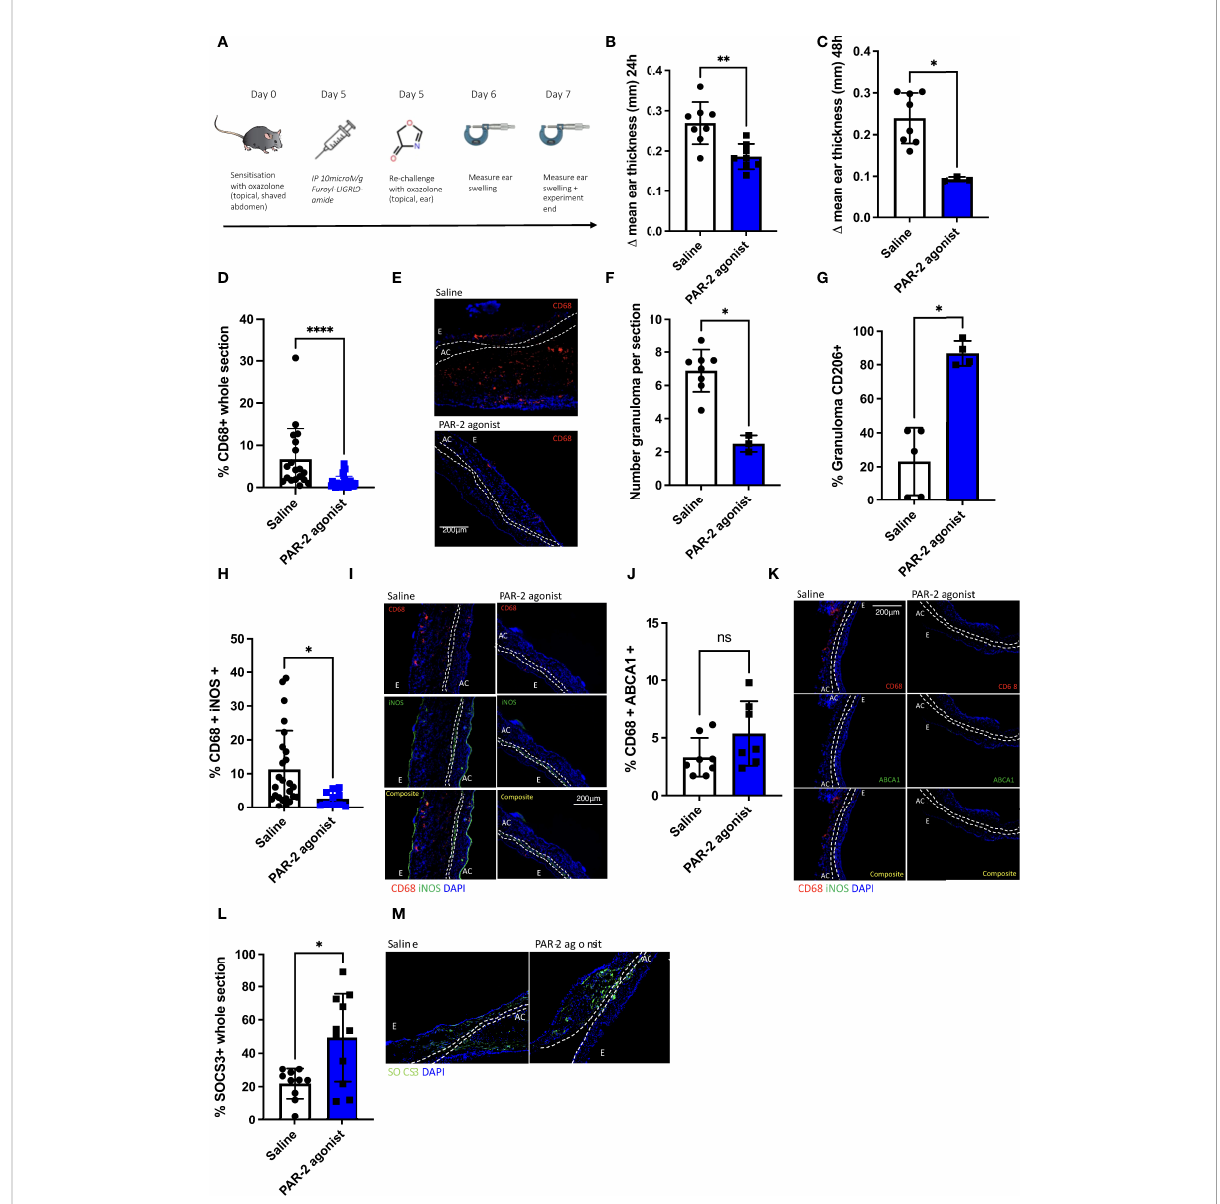
FIGURE 2 PAR-2 signalling delivers a protective phenotype in oxazolone induced delated type hypersensitivity. (A). Schematic illustrating the experimental protocol. C57BL/6 (WT) mice were sensitised on the abdomen with oxazolone on day 0 and re-challenged on day 5 on one of the ears with oxazolone, and on the other ear with vehicle alone. Immediately prior to re-challenge, mice received either IP saline (n= 8) or 10microM/g PAR-2 agonist (n= 7). 24 and 48 hours following re-challenge (days 6 and 7), ear swelling was quanti fi ed using a micrometer. Data are presented as D mean ear thickness (swelling of oxazolone-treated ear minus that of vehicle treated ear). At least 5 measurements were taken per ear and averaged. (B, C). D mean ear thickness at 24HRS (day 6) (B) and 48HRS (day 7) (C) post re-challenge with oxazolone. (D – M). Immuno fl uorescence offrozen sections through oxazolone-treated ears. Bars represent means + SD for saline treated mice (white) or PAR-2 agonist-treated mice (blue). (D). In fi ltration of CD68 + cells: % area of the section occupied by CD68 + cells. (E). Representative two colour IF sections through oxazolone-painted ears. Images show staining with CD68 (red) and DAPI (blue). (F). Number of granuloma per section at 100x magni fi cation: Granuloma was classi fi ed as an aggregation of cells co-localisation of DAPI and CD68 at an area of outpouching from the epidermis. (G). % CD206 expression within granulomata. (H – K). Proportion of CD68 + cells co-expressing iNOS (H+I) or ABCA1 (J+K). I+K Representative three colour IF sections through oxazolone-painted ears. Images show staining with CD68 (red) iNOS (green -I), ABCA1 (green -K) and DAPI (blue). (L, M). Proportion of whole section SCOS3 expression. Bars represent means + SD for saline treated mice (white) or PAR-2 agonist-treated mice (blue) (L, M) . Representative two colour IF sections through oxazolone-painted ears. Images show staining with SOCS3 (green) and DAPI (blue). For representative IF images dotted lines demarcate the auricular cartilage (AC). E= epidermis. All Samples were compared using a Mann Whitney U test with two tailed p-values. Bar data represents mean +SD. *P < 0.05 **P < 0.01 ****P < 0.0001). ns, non signi fi